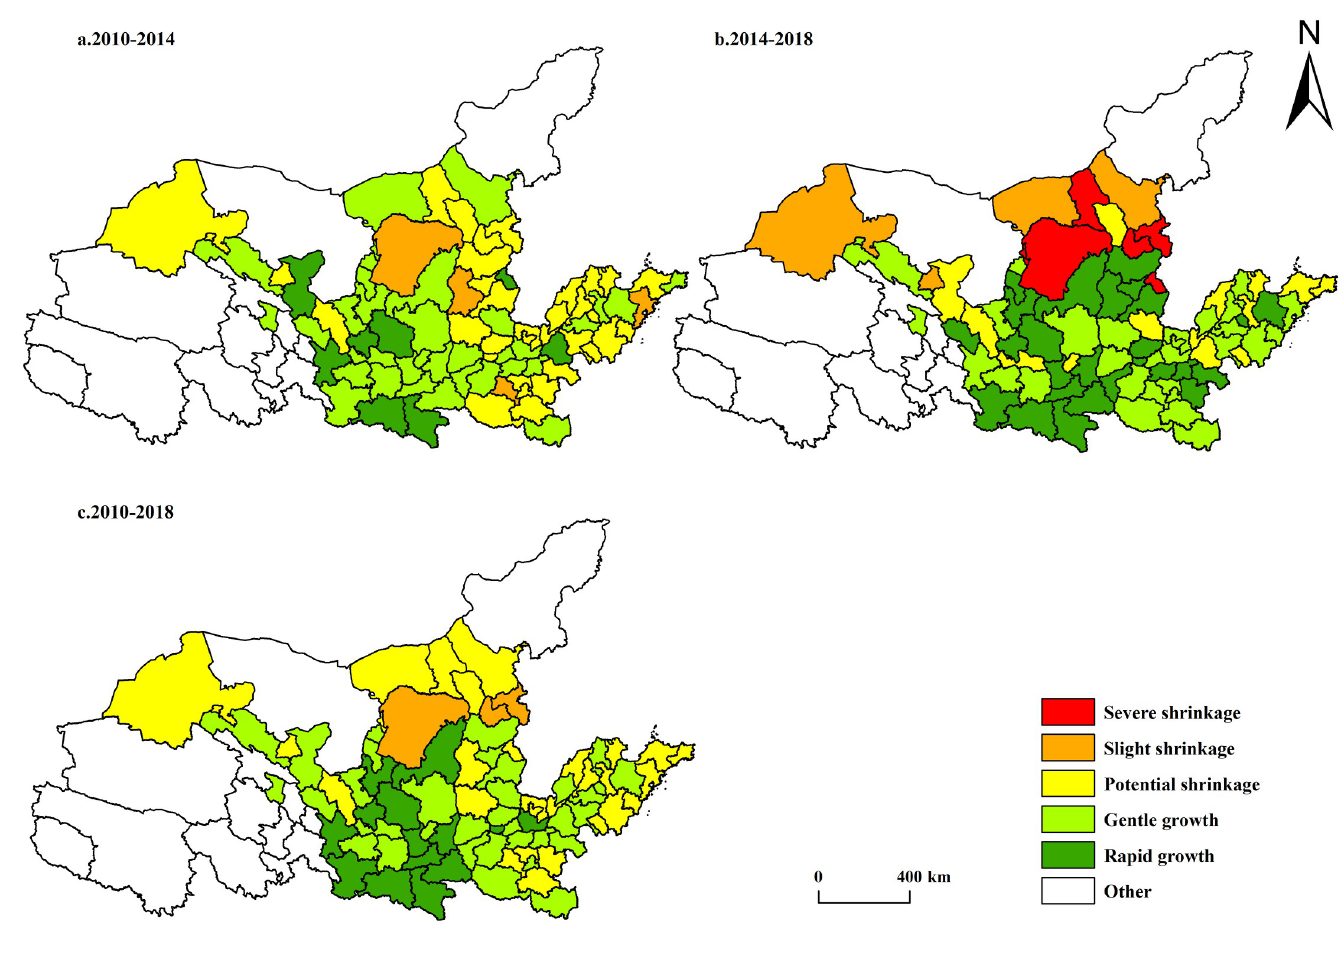
Fig 3. Spatiotemporal differentiation of economically-shrinking cities in the Yellow River Basin. The basic map came from a public map from the standard map service website of the Ministry of Natural Resources of China. The drawing approval number is GS